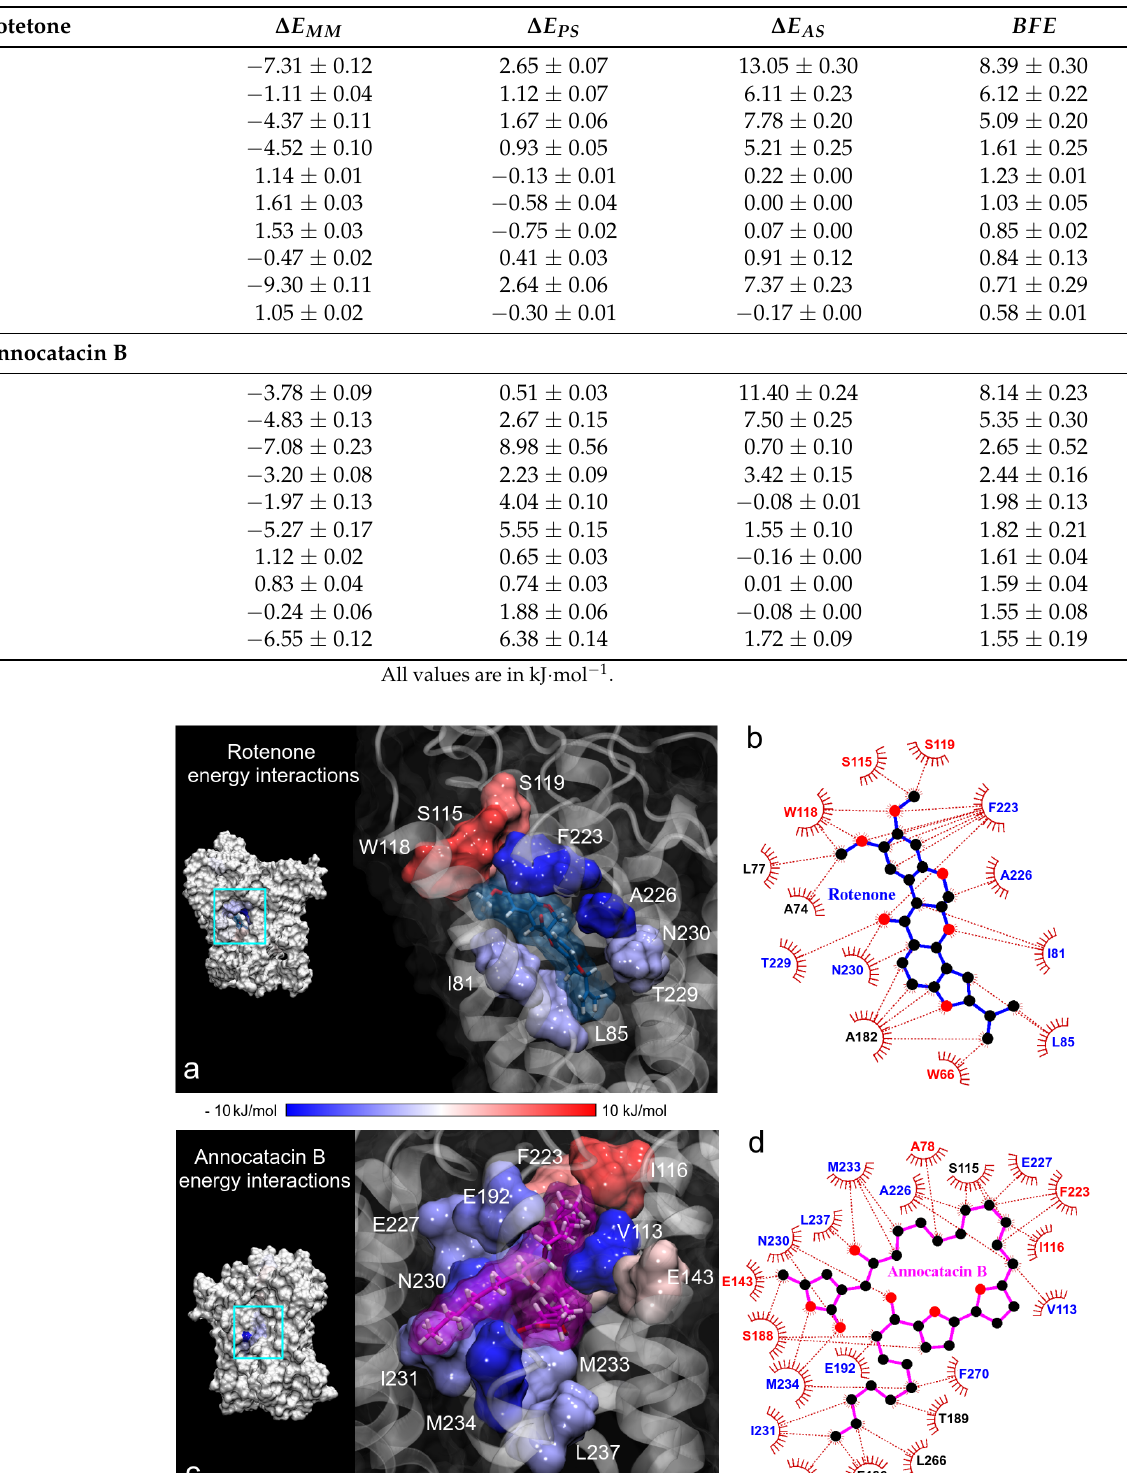
Table 7. Top 10 residues that does not contribute to the binding free energy.